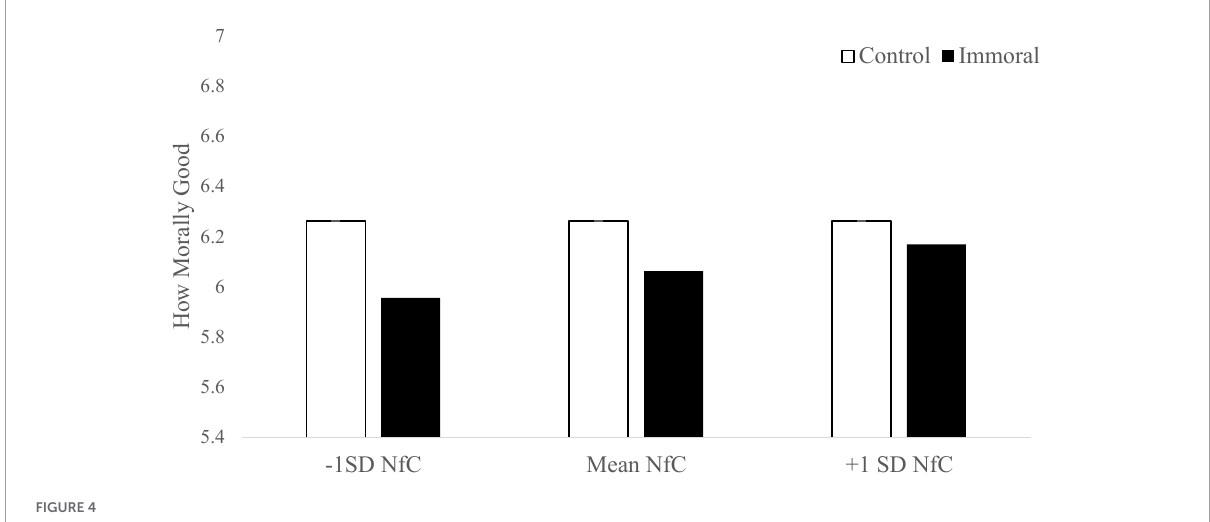
FIGURE4 Interaction of need for cognition with moral